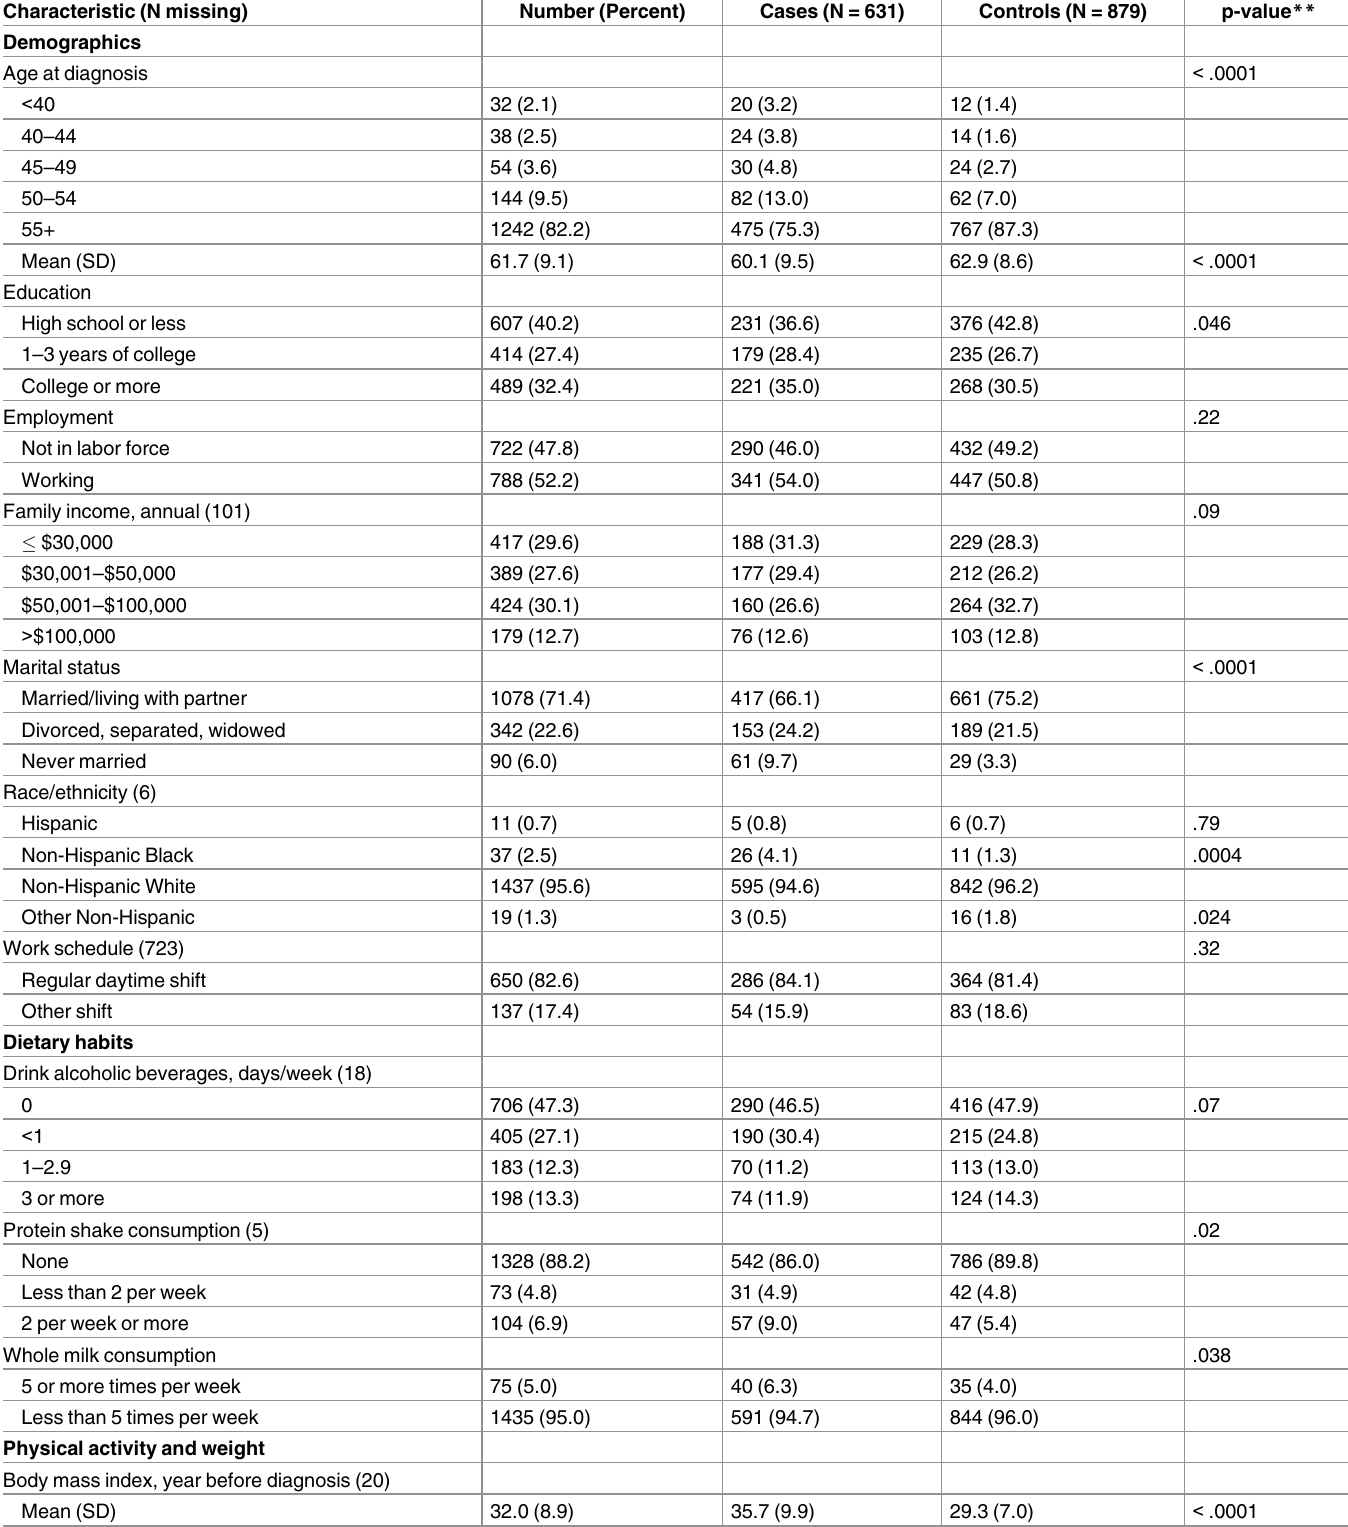
Table 1. Characteristics of endometrial cancer casesand population-based controls *